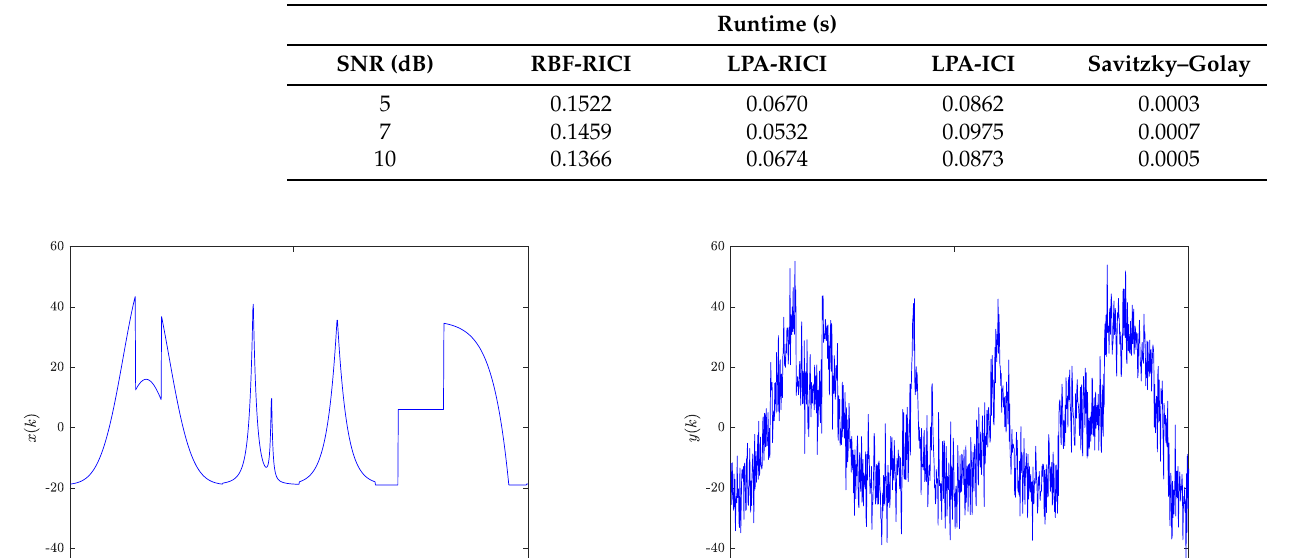
Table 35. Piece-Regular signal—Filtering algorithms’ runtimes.